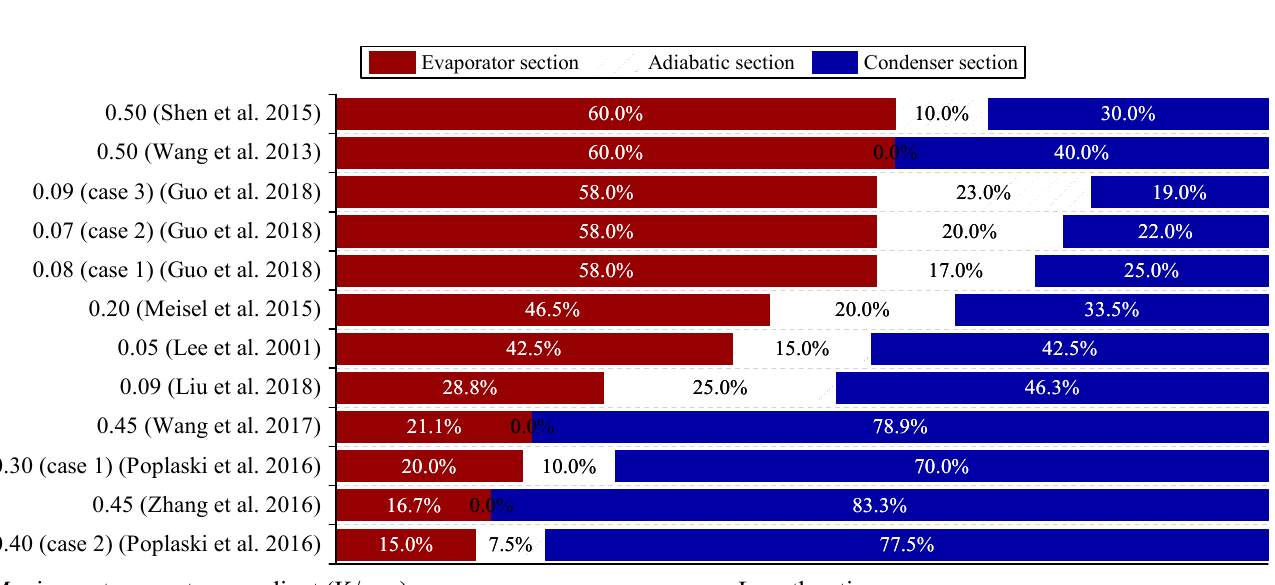
Figure 2. Effect of the isothermal performance on length ratio of each section of heat pipes.